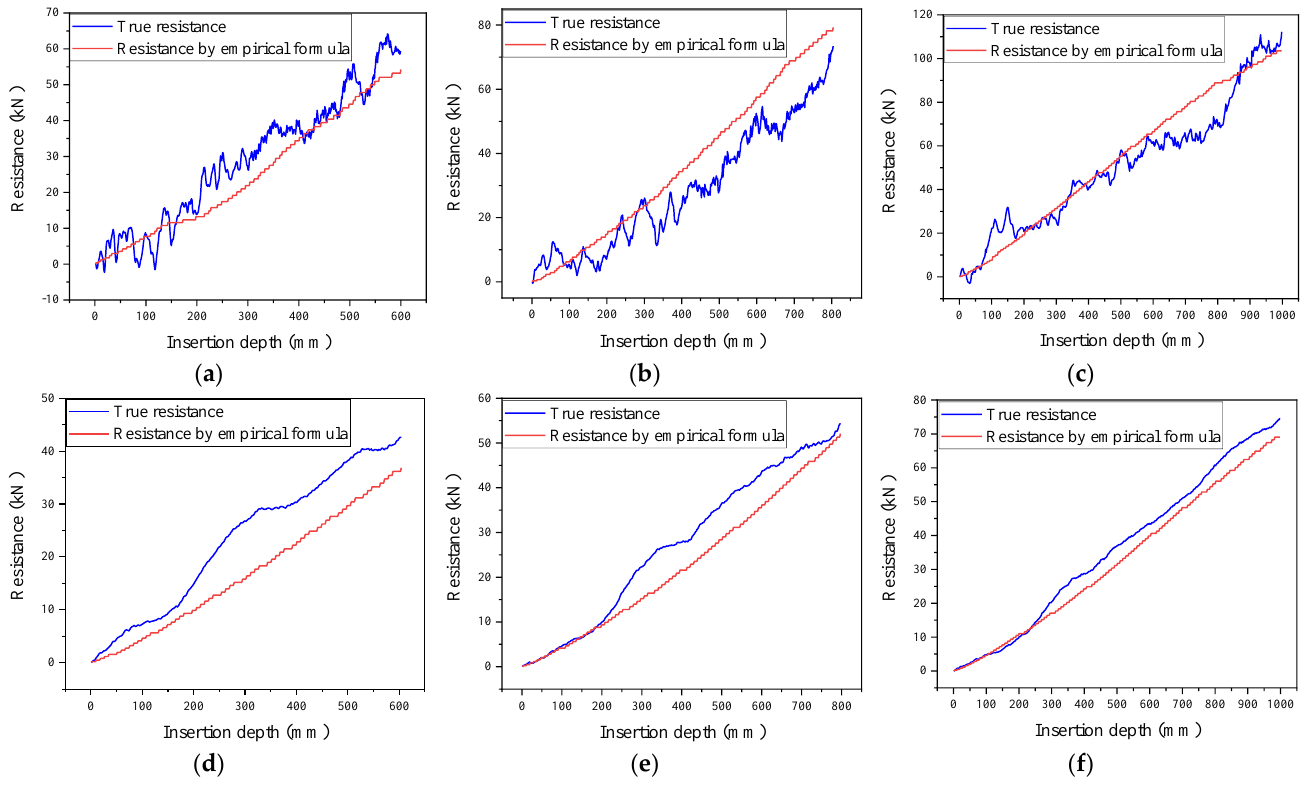
Figure 8. Insertion resistance. ( a ) The gravel pile with an insertion depth of 600 mm; ( b ) The gravel pile with an insertion depth of 800 mm; ( c ) The gravel pile with an insertion depth of 1000 mm; ( d ) The sand pile with an insertion depth of 600 mm; ( e ) The sand pile with insertion depth of 800 mm; ( f ) The sand pile with insertion depth of 1000 mm.